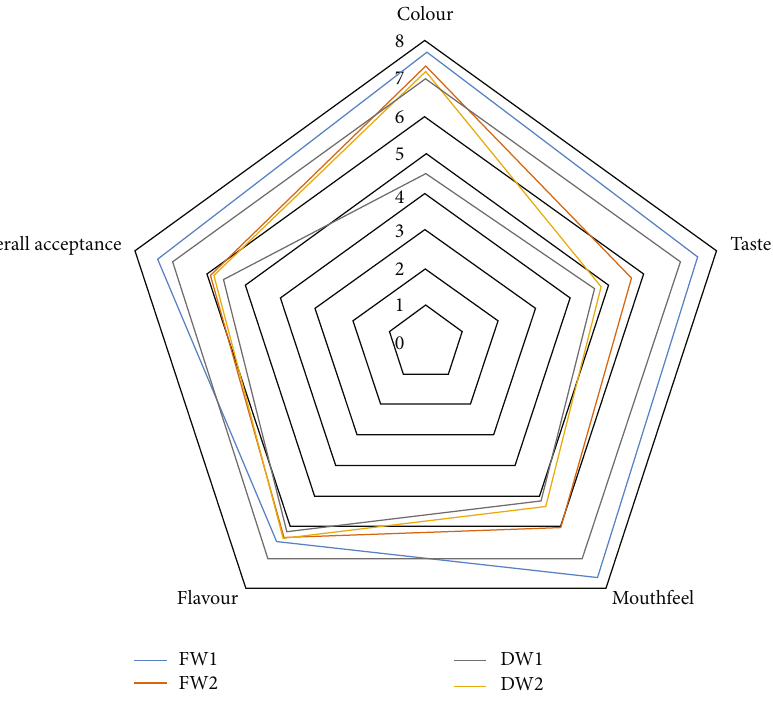
Figure 3: Sensory perception of foreign and domestic wines.